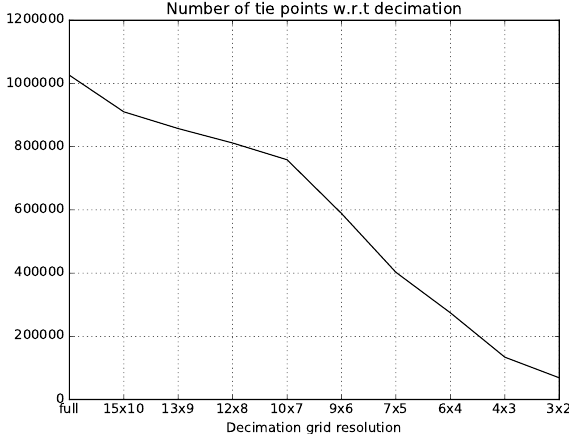
Figure 3: Number of tie points for different decimation grid res- olutions.